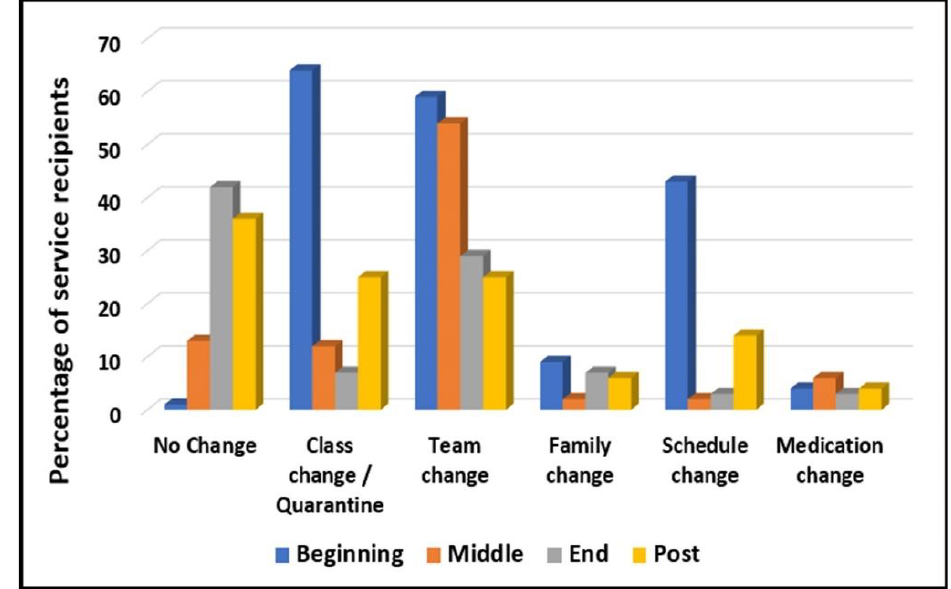
Figure 4. Environmental changes for 76 Adults with ID (September 2020 – June 2022).